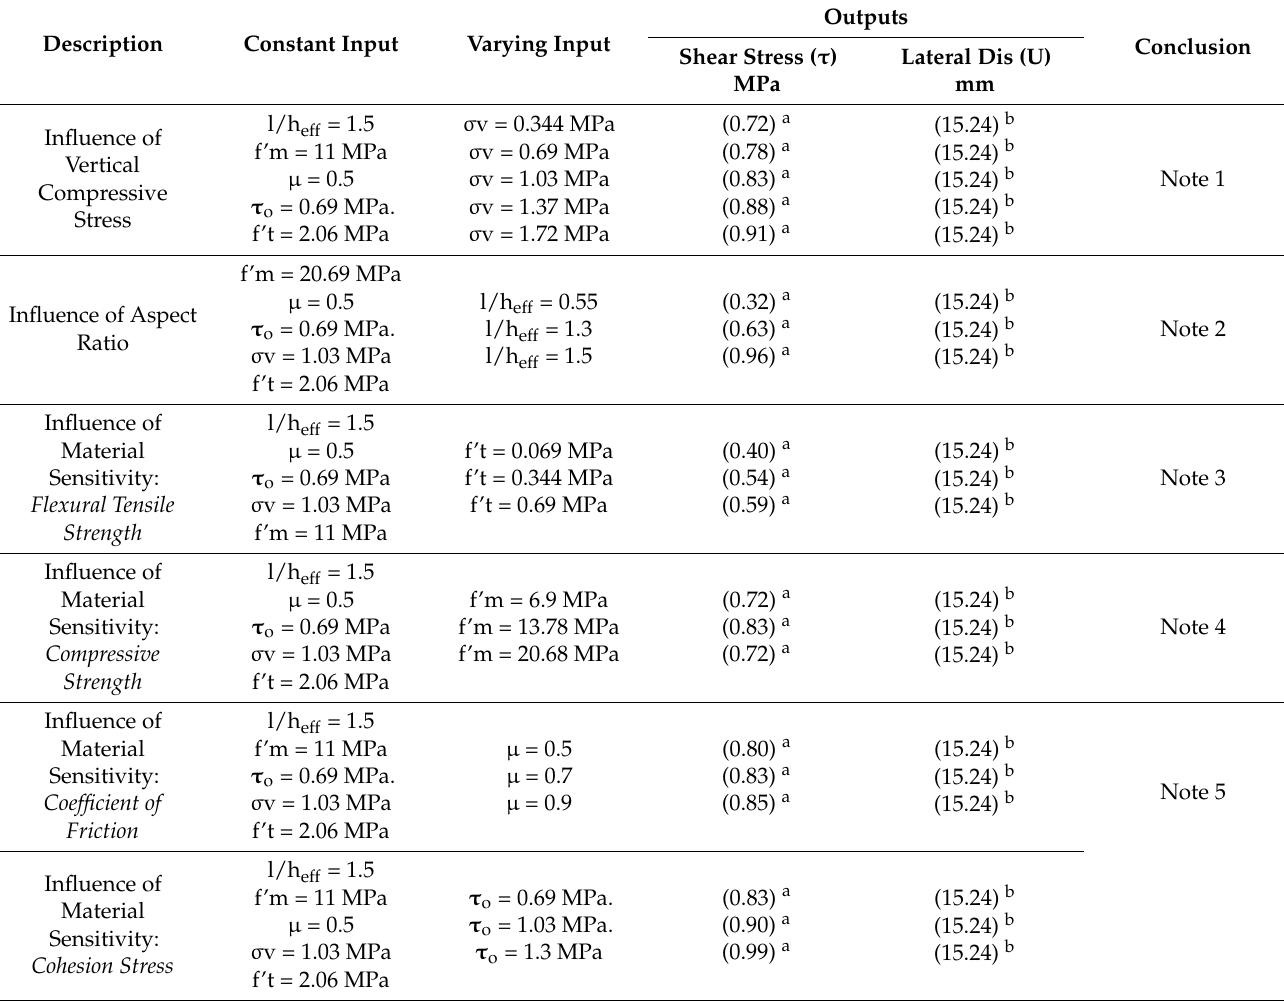
Table 4. Classification of parameters and models in the parametric study of URM walls carried out in this study (see footnote after the table for the conclusion